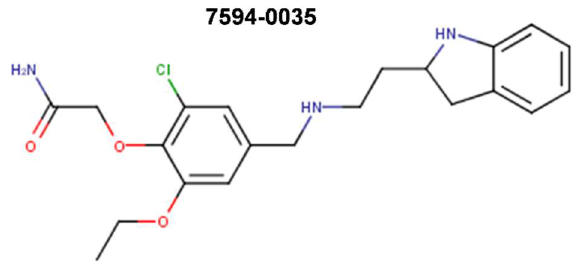
Figure 10. Chemical structure of 7594-0035 Myc-Max inhibitor identified in silico utilizing the Myc-Max 1NKP X-ray structure, yet targeting a previously reported disordered binding region for 10074-G5 but in ordered form. See Section 3.1.4 for further details.